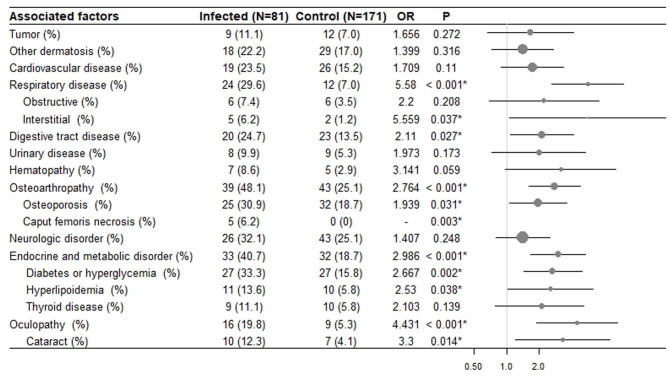
The risk of infection in BP patients with different comorbidities. In all 252 BP patients, 171 had no infectious complication, and 81 had infections. The odds ratios (OR) and p values were calculated. *Denotes statistical significance (p < 0.05). Forest plots show odds ratios of different comorbidities with a 95% confidence interval.